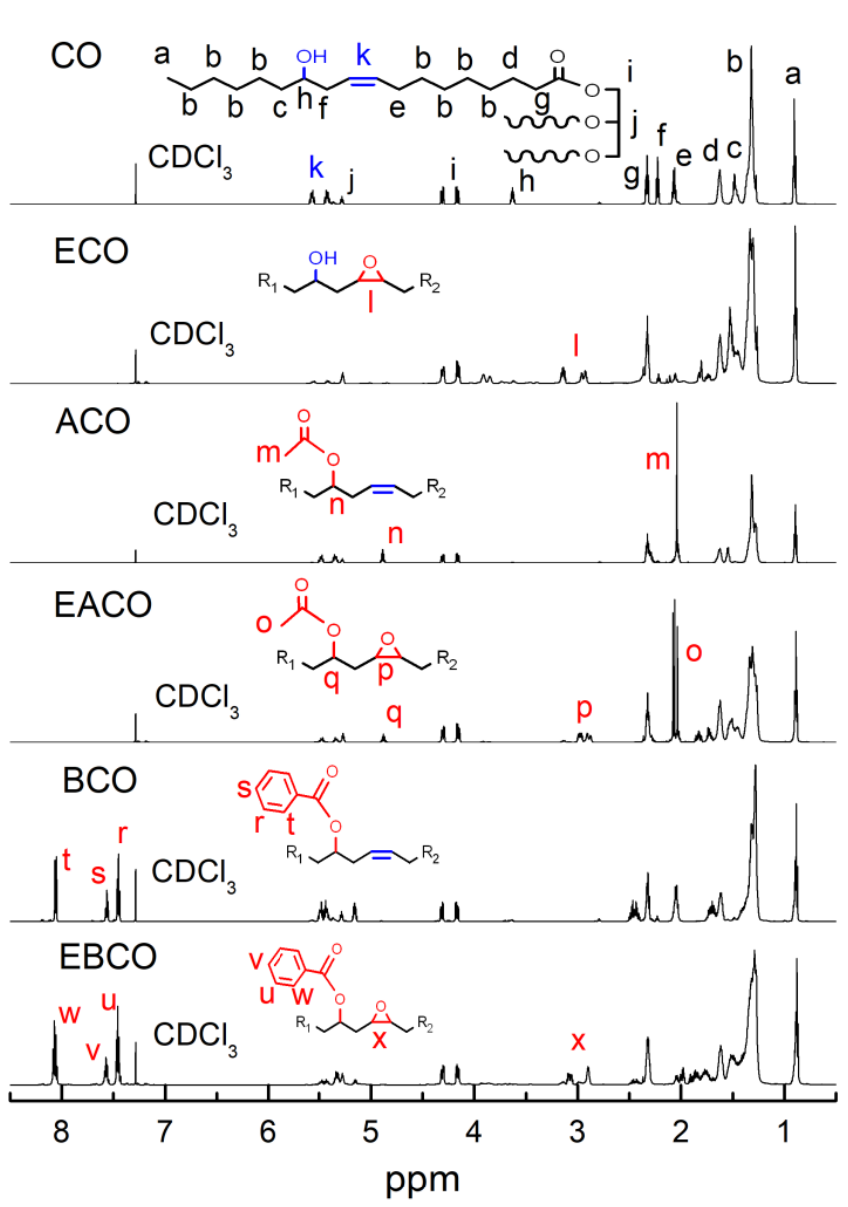
Figure 2. 1 H NMR spectrum of CO, ECO, ACO, EACO, BCO, and EBCO.